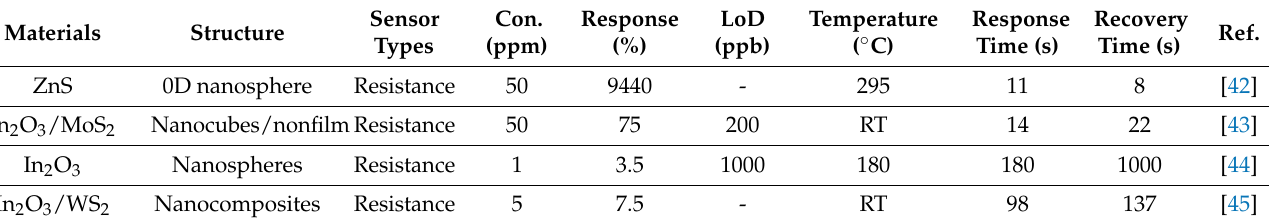
Table 1. Sensing performances of recently reported CH 2 O sensors.